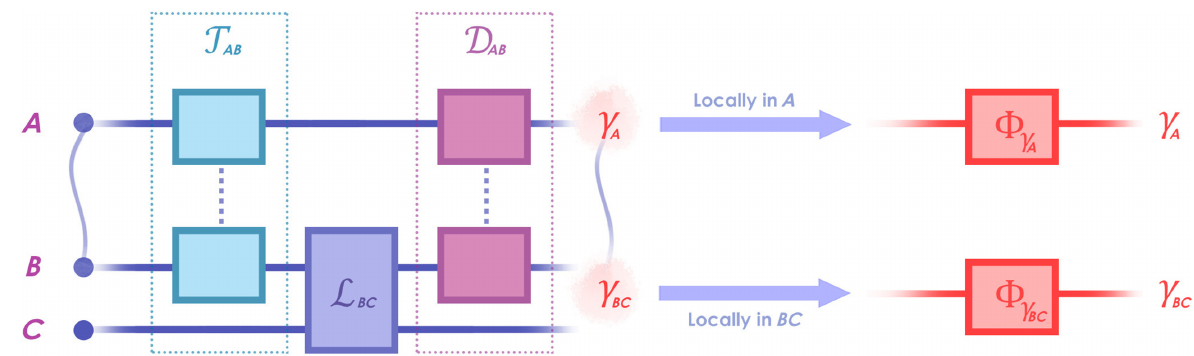
FIG. 2. Schematic interpretation of Eq. (I1) and Theorem I.2. We use κ = κ ∗ as an example. As shown in the figure, the channel E V , κ = κ ∗ can be decomposed into three steps. First, a ( U ⊗ U ∗ ) -twirling operation T AB is applied, which requires only local unitary A | BC operations and shared randomness (the thick dashed line). After that, the channel L BC = L V is applied locally in the subsystem BC . BC can be achieved. The resulting global channel has the property that, Finally, using shared randomness again, the channel D AB = D κ ∗ AB when one only observes it locally in A and BC , it is identical to a full thermalization channel; namely, a state preparation channel (cid:16) ( · ) : = γ ( · ) of the given thermal state in the subsystem X , where X = A or BC . Still, as shown in this section, this channel is γ X X tr able to preserve entanglement in the AB bipartition, and it is also possible to transmit classical information by encoding the information into the global correlation shared by A and B